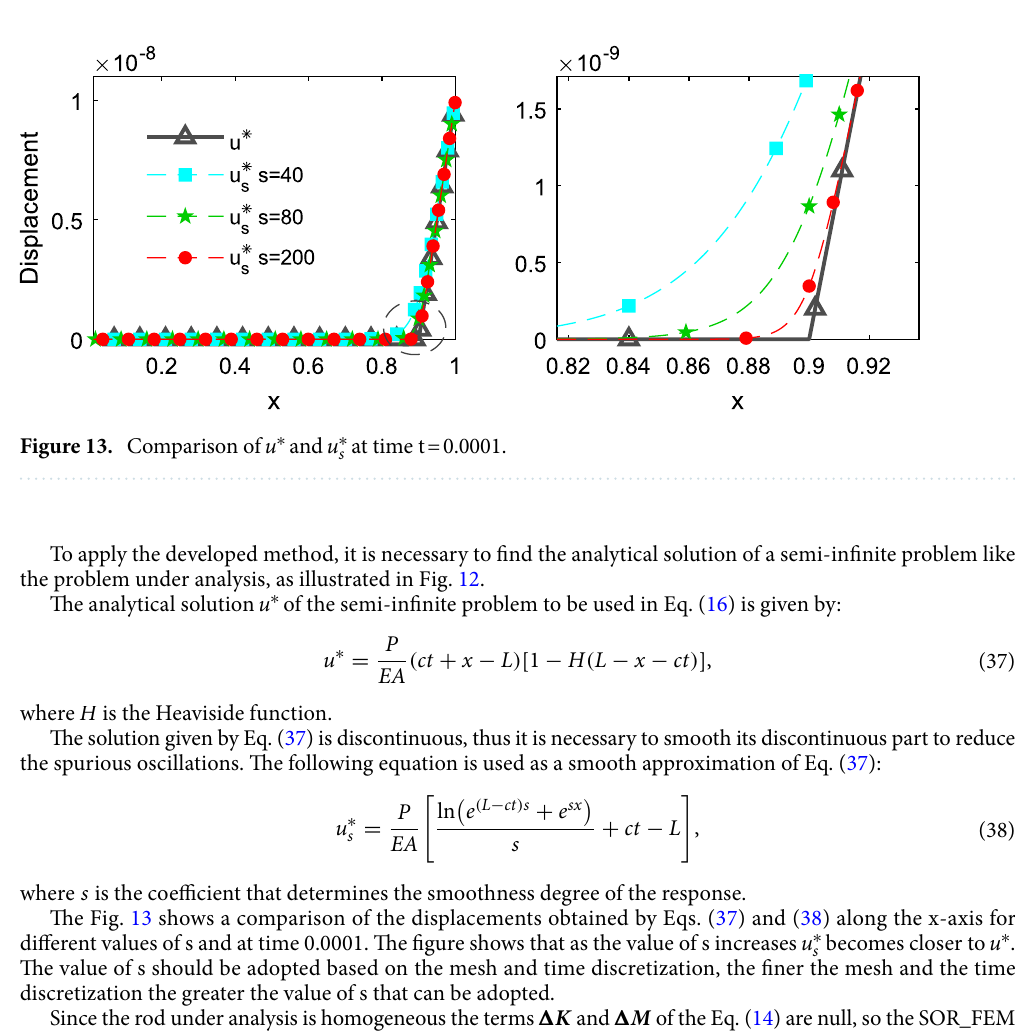
Figure 12. Representation of the semi-infinite media problem used to obtain u*.